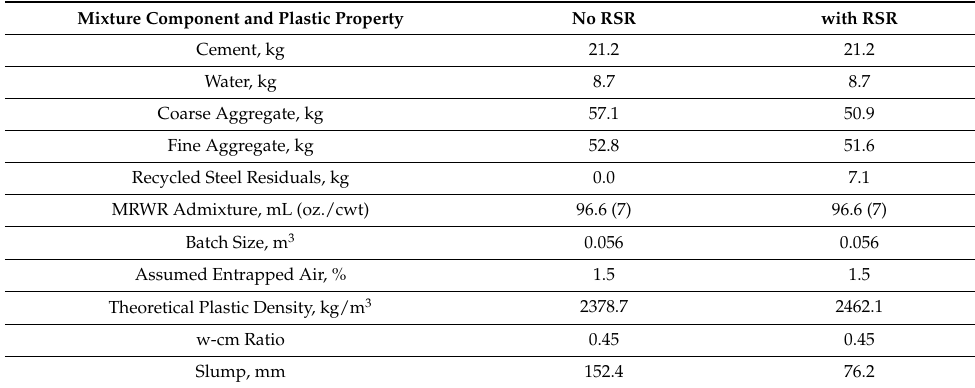
Table 2. Batch Weights of Trial Concrete Mixtures Based on RSR